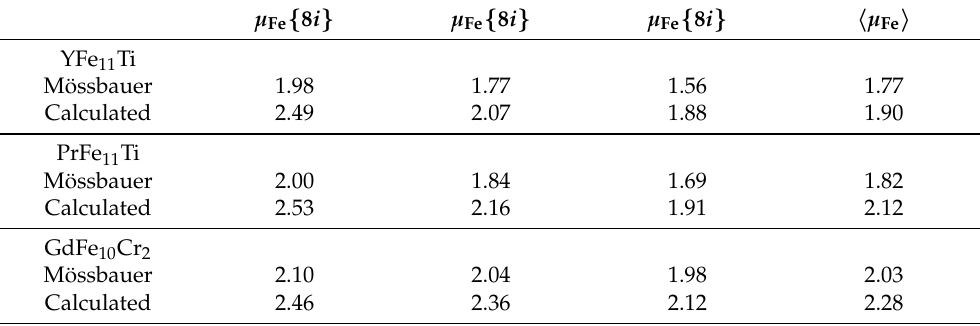
Table 10. Comparison between magnetic moments, in µ B /at., obtained by experimental measurements (Mössbauer Spectrometry) and by DFT calculations for YFe 11 Ti, PrFe 11 Ti, and GdFe 10 Cr 2 [84,86]. µ Fe { 8 i } µ Fe { 8 i } µ Fe { 8 i } (cid:104) µ Fe